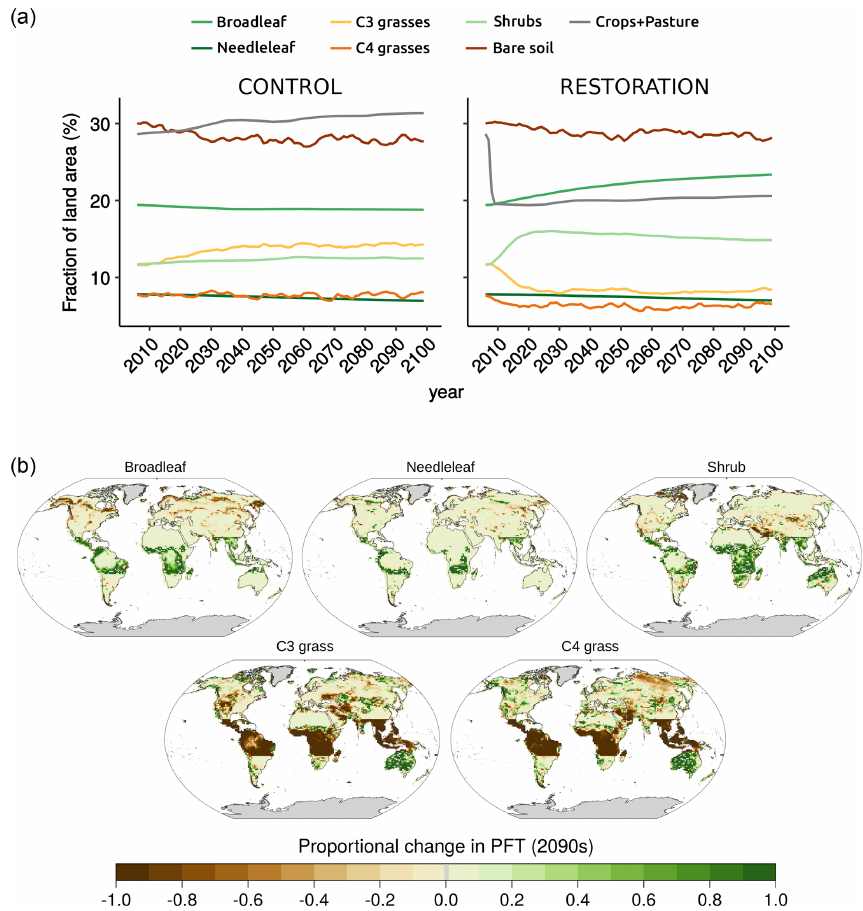
Figure 1. (a) Change in land cover (2006–2100CE) in control (left) and restoration (right) simulations. Urban (0.1%), inland water (1.9%), and ice fraction (9.7%) are constant and not included. An anthropogenic land-use mask is added on top of other land-cover types, replacing woody PFTs with bare soil and preventing woody PFTs from replacing grassy PFTs, which include crops and pasture (see Sect. 2.1.1). (b) Spatial difference in land cover in the restoration simulation relative to the control simulation over the 2090s. A change of 1 represents a doubling of that land-cover type relative to the control simulation, a change of − 1 means a reduction of